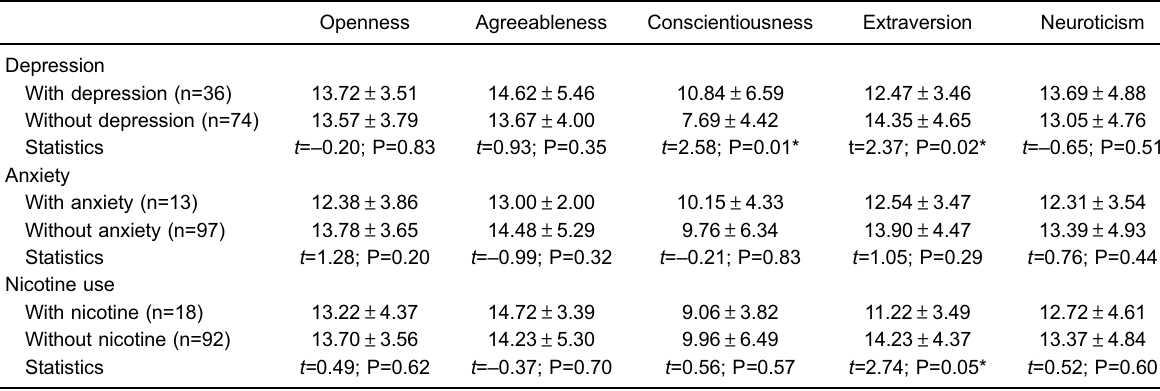
Table 4. Scores on different personality traits among alcoholics with different psychiatric